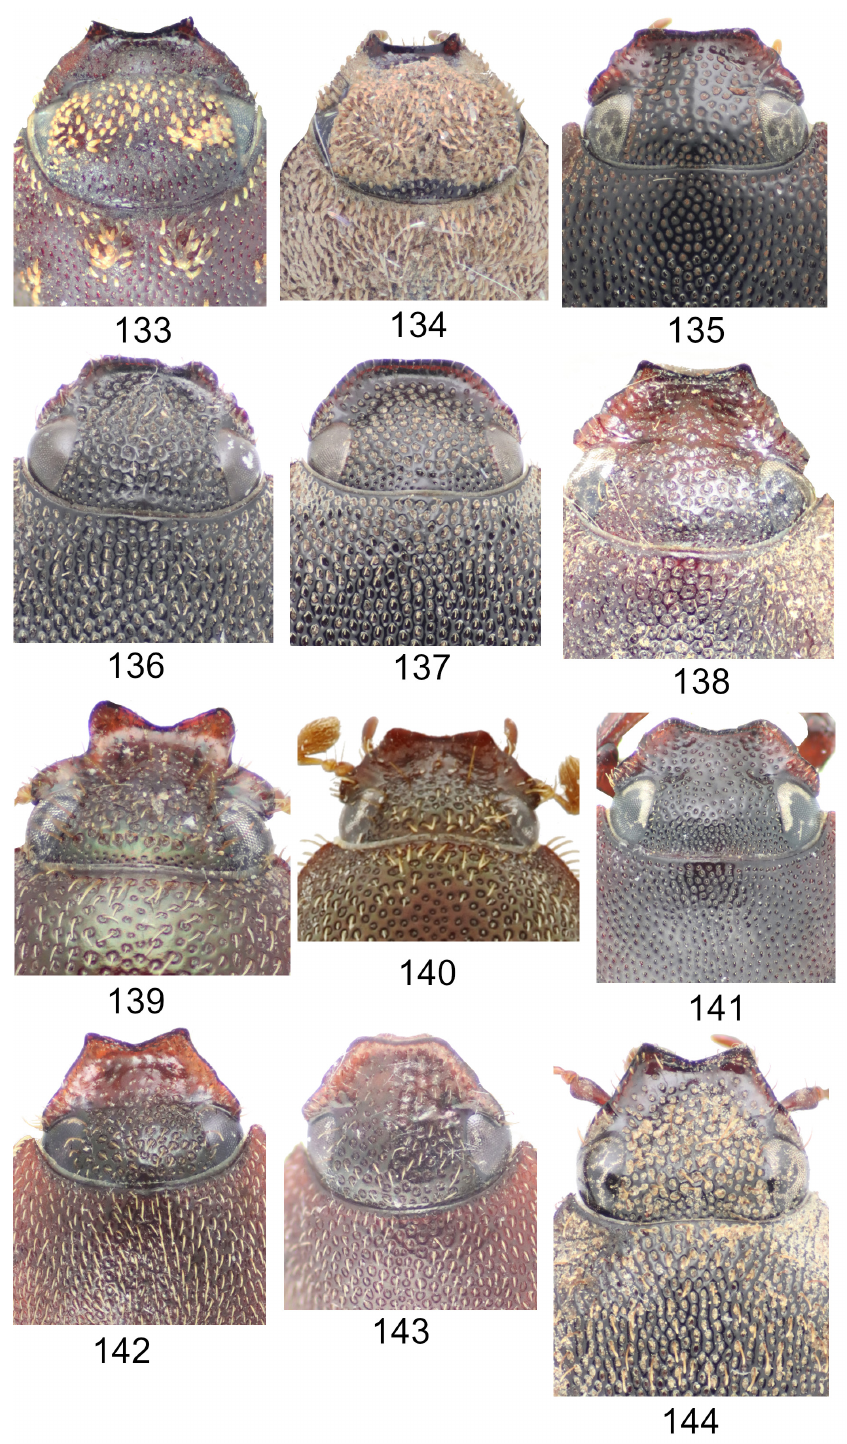
Figs 133–144. Papuan and Wallacean Maechidius Macleay, 1819, head, dorsal view. 133 . M. lapsus sp. nov., holotype, ♂ (BMNH). 134 . Same, paratype, ♀ (BMNH). 135 . M. lineatopunctatus Frey, 1969, holotype, ♂ (NHMB). 136 . M. legalovi sp. nov., holotype, ♂ (BMNH). 137 . Same, paratype, ♀ (BMNH). 138 . M. longipes sp. nov., holotype, ♂ (BMNH). 139 . M. lobaticeps Frey, 1969, ♂ (BMNH). 140 . Same, ♀. 141 . M. mailu sp. nov., holotype, ♂ (NHMB). 142 . M. luniceps Fairmaire, 1883, ♂ (BMNH). 143 . Same, ♀ (BMNH). 144 . M. maleo sp. nov., holotype, ♂ (IRSN). Not to